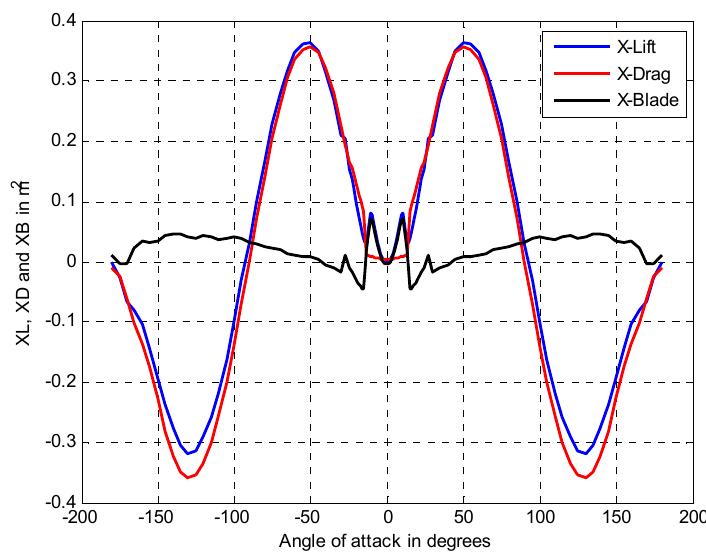
Figure 17. Reactive element variations as functions of the angle of attack.